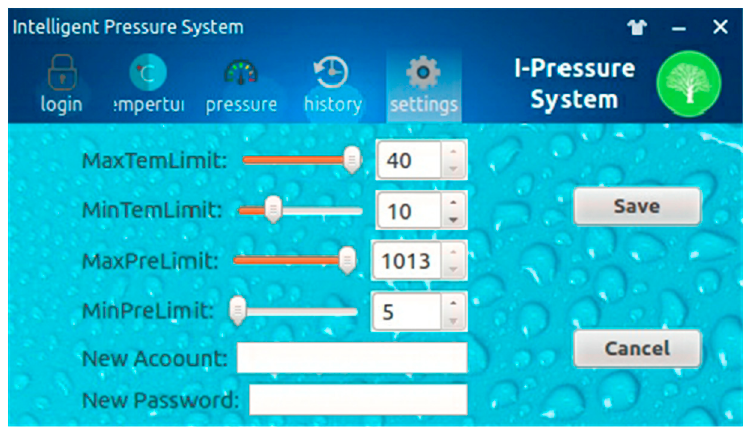
Figure 13. Software system framework of the array-type intelligent pressure sensor.